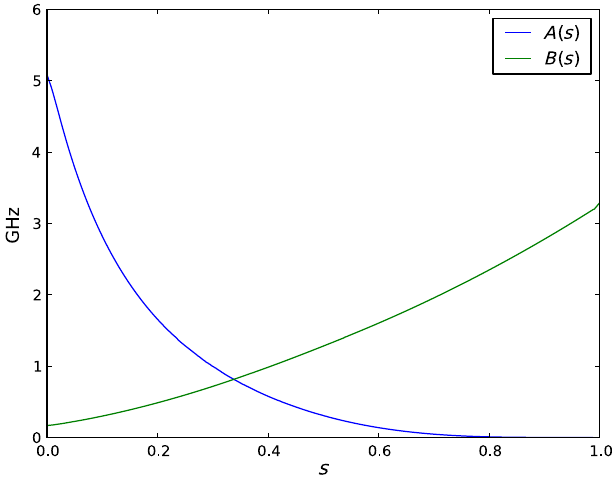
FIG. 8. Quantum annealing schedules employed by the D- Wave processor, where s ¼ t=t f